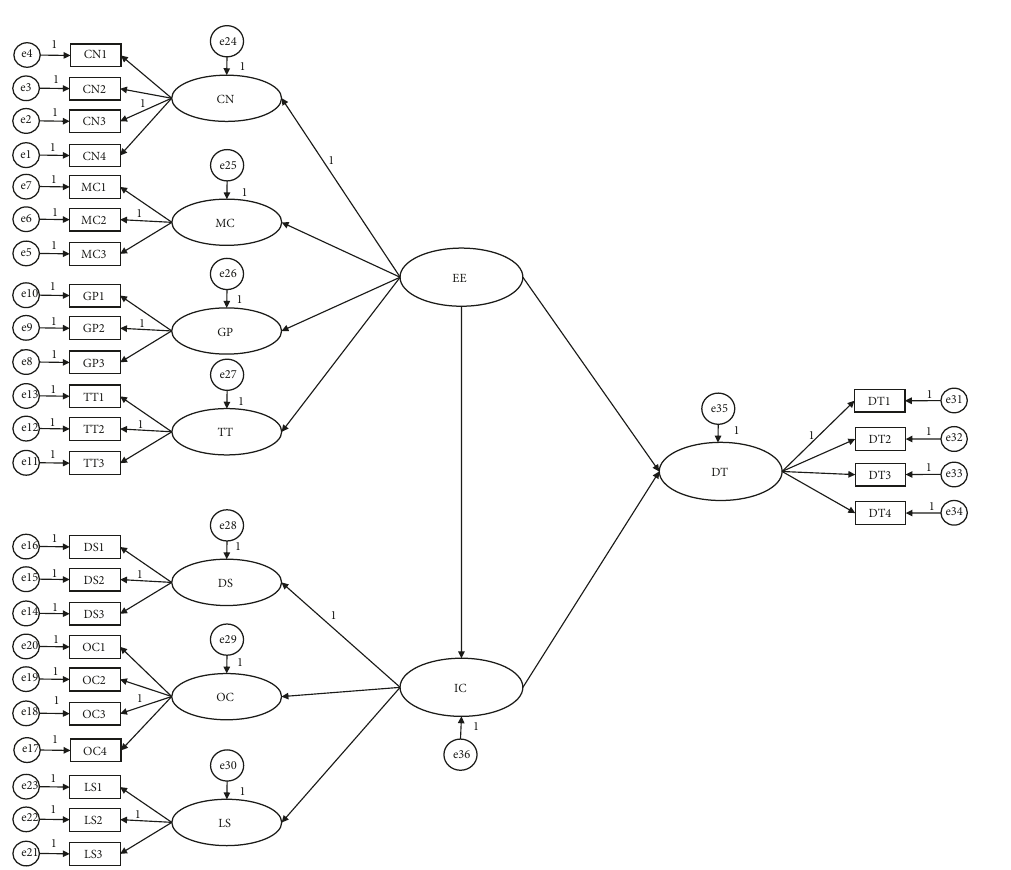
Figure 4: SEM of pharmaceutical enterprises’ DT. Table 9: Fitting indexes of influencing factor model of pharmaceutical enterprises’